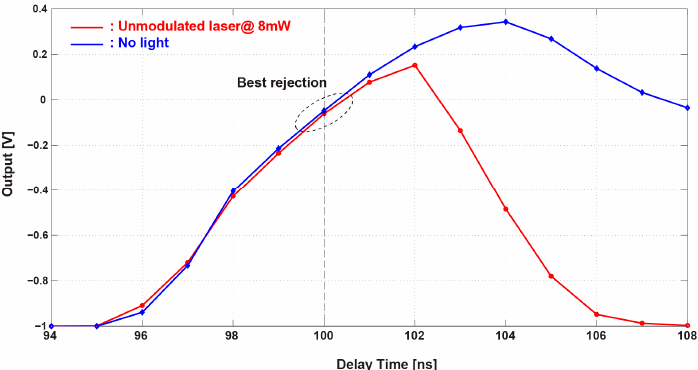
Figure 16. Delay time adjustment to minimize the residual offset in the pixel output.